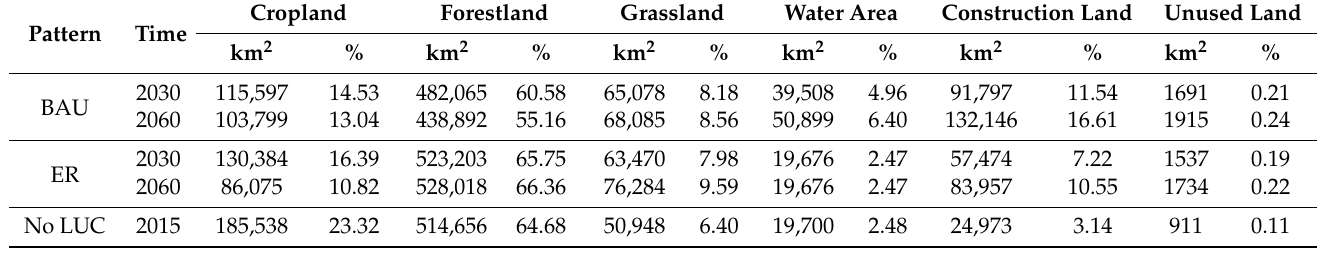
Table 2. Comparison of land use type areas under three LUC patterns.